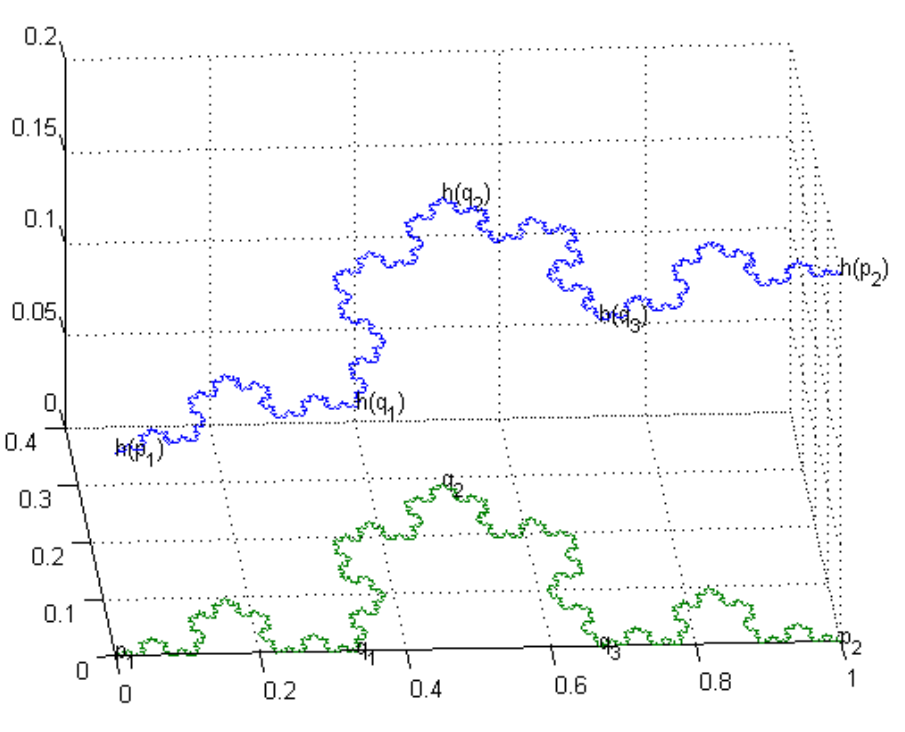
Figure 5. A harmonic function on the Koch